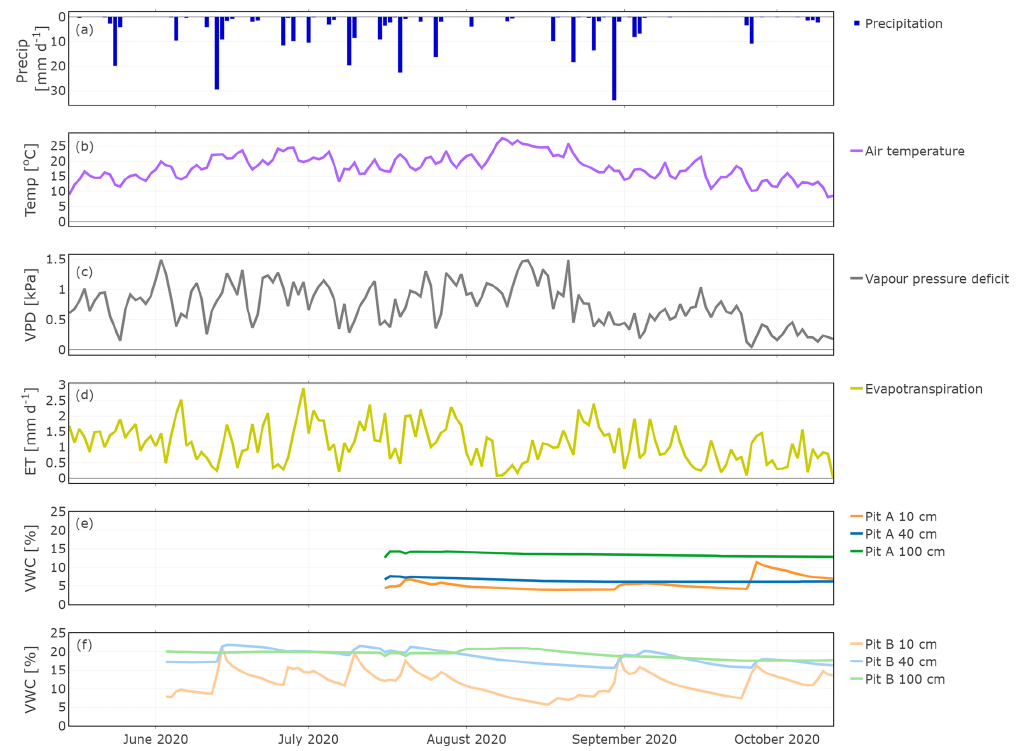
Figure 3. Hydroclimatic conditions showing daily precipitation (a) , air temperature (b) , vapour pressure deficit (c) , evapotranspiration (d) , and soil moisture for Pit A (e) and Pit B (f)